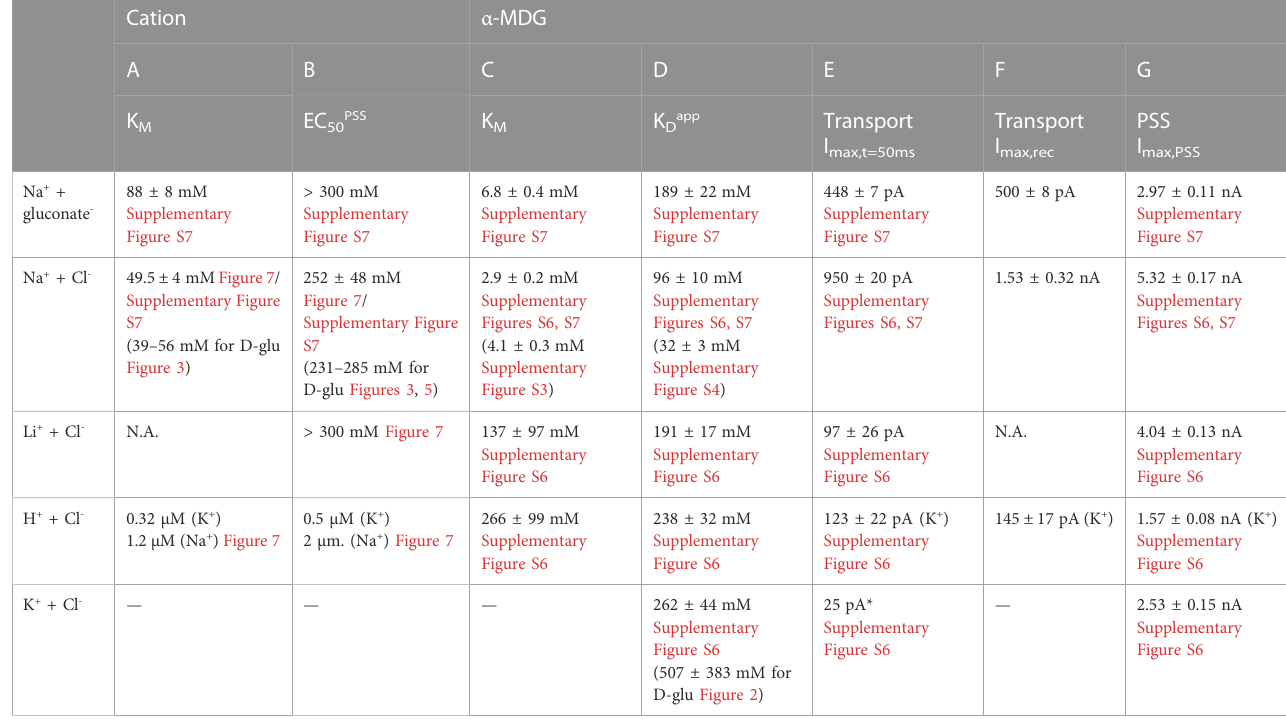
TABLE 2 Kinetic parameters obtained from transport and PSS currents using different cations and anions upon MDG concentration jumps. Cation α -MDG A